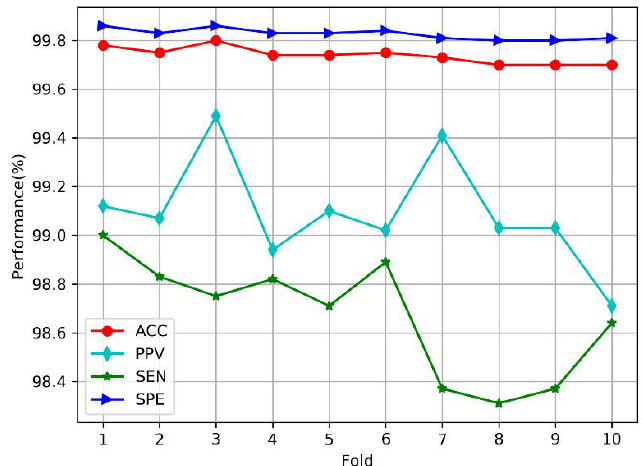
Figure 9. Plots of performance measures versus the number of folds under intra-patient paradigm.